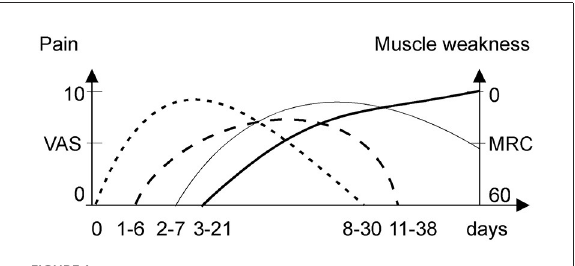
FIGURE1 Onset and duration of pain syndromes and weakness during an acute attack. MRC, medical research council; VAS, visual acuity scale. Abdominal pain (dotted line), back pain (dash line), limb pain (thick solid line), and muscle weakness (thin solid line).